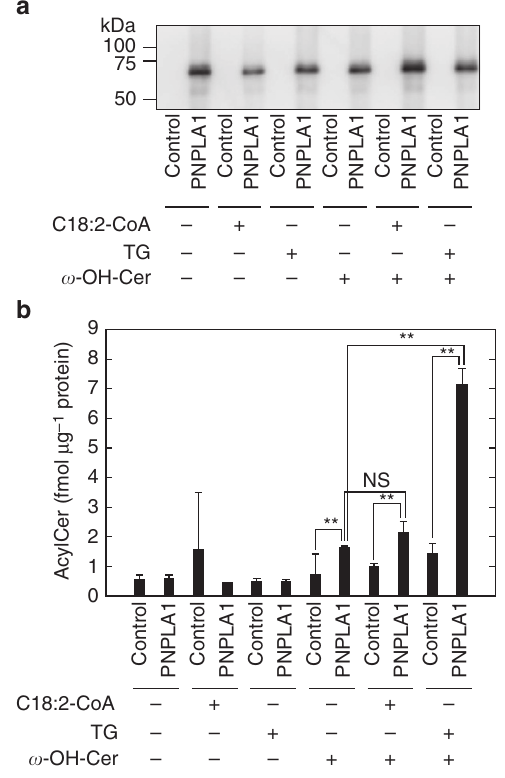
Figure 5 | PNPLA1 catalyses acylceramide synthesis via transacylation. SP6 RNA polymerase was used in vitro to transcribe genes from control plasmid (pEU-E01-T1R1) or plasmid encoding wild-type PNPLA1 (pEU-E01- 3xFLAG-PNPLA1). The resulting mRNAs were then incubated with wheat germ lysates and phosphatidylcholine-based liposomes containing linoleoyl-CoA (C18:2-CoA), TG, and C30:0 o -hydroxyceramide